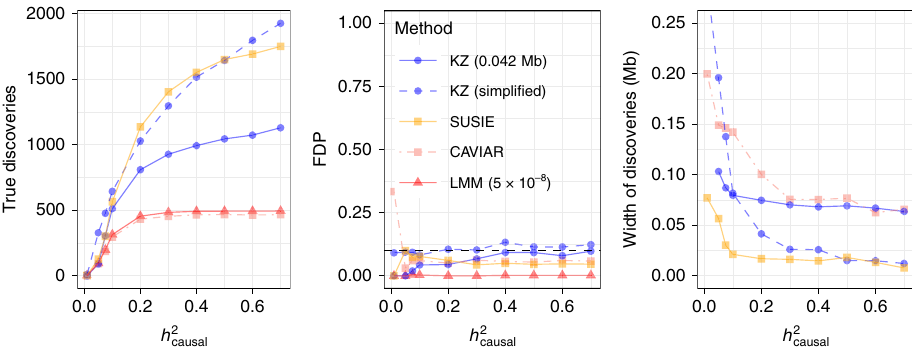
Fig. 4 Fine mapping in simulations. KnockoffZoom compared with a two-step fi ne-mapping procedure consisting of BOLT-LMM followed by CAVIAR or SUSIE, in the same simulations as in Fig. 3. Our method, CAVIAR, and SUSIE control a similar notion of FDR at the nominal level 0.1.